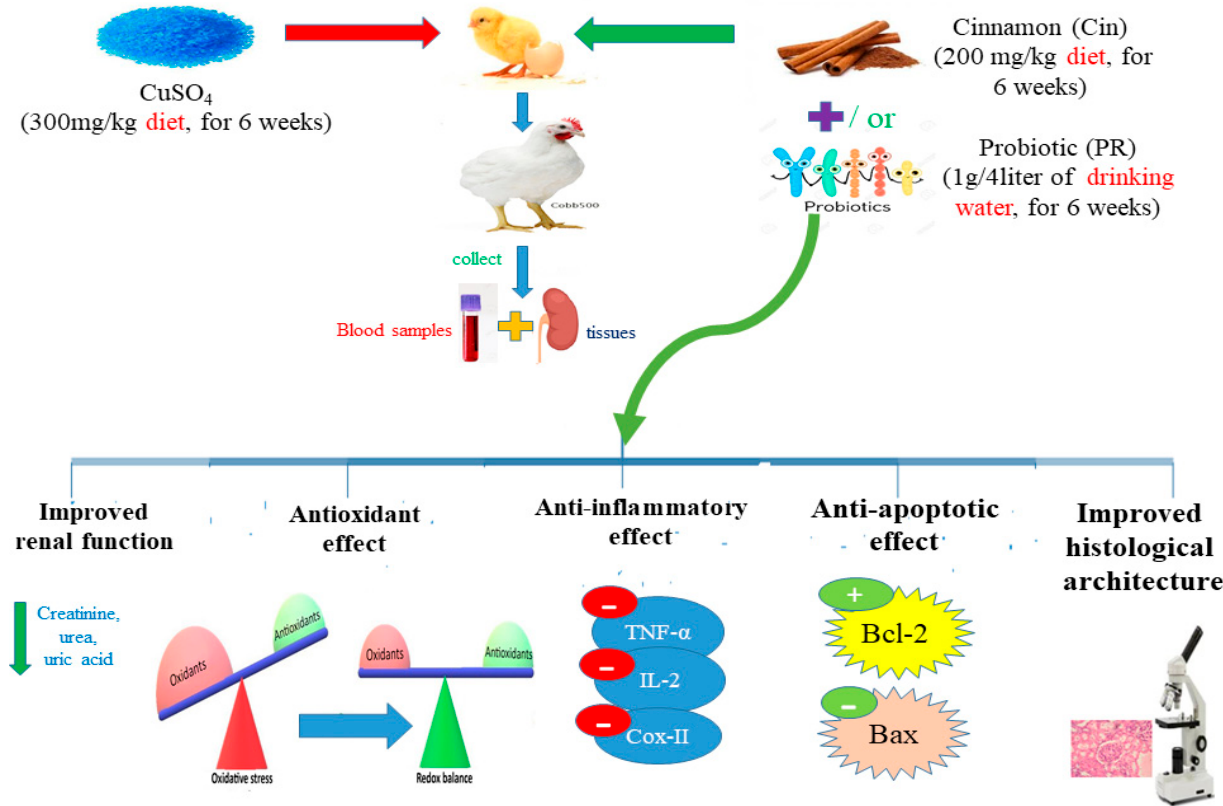
Figure 1. The experimental design and the possible mechanisms of Cin and probiotic preventing Cu-caused renal injury in broilers.